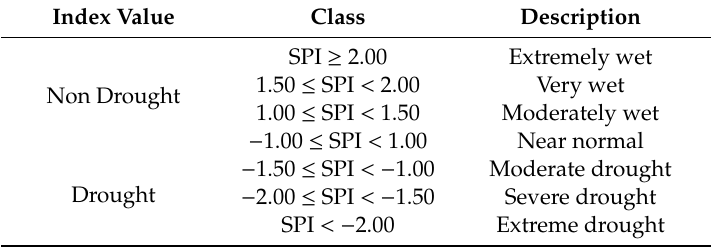
Table 1. Wet and drought period classification according to the SPI index